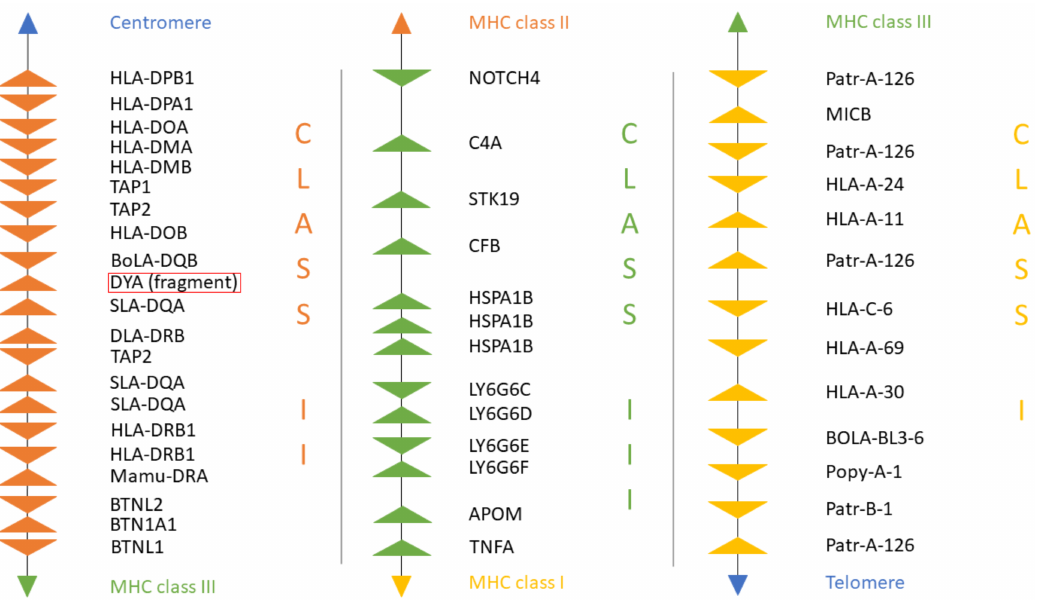
Figure 7. The organization of the MHC region in C. dromedarius . MHC class II genes are shown in orange. MHC class III genes are shown in green. MHC class I genes are shown in yellow. Spaces between genes do not represent real distances. Details of the annotation are available in Table S8.